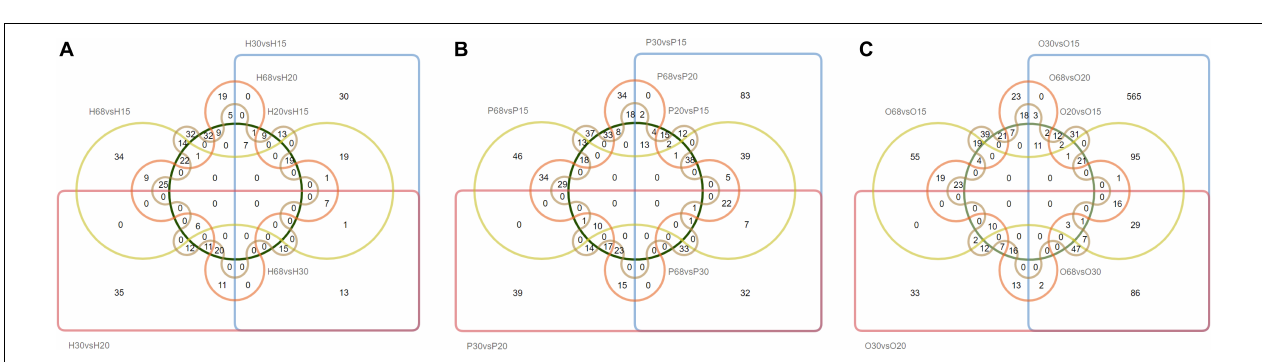
FIGURE 1 | Number of DEGs in the three tissues from the HPO axis at four different ages. The name of the abscissa consists of letters and numerals, the capital letters correspond to the tissue (H: hypothalamus; P: pituitary; and O: ovary), while the numerals indicates the weeks of age (i.e., 15, 20, 30, and 68 w). This naming convention is the same in the following figures. The blue bars represent the number of significantly down-regulated DEGs while red bars represent significantly up-regulated DEGs.